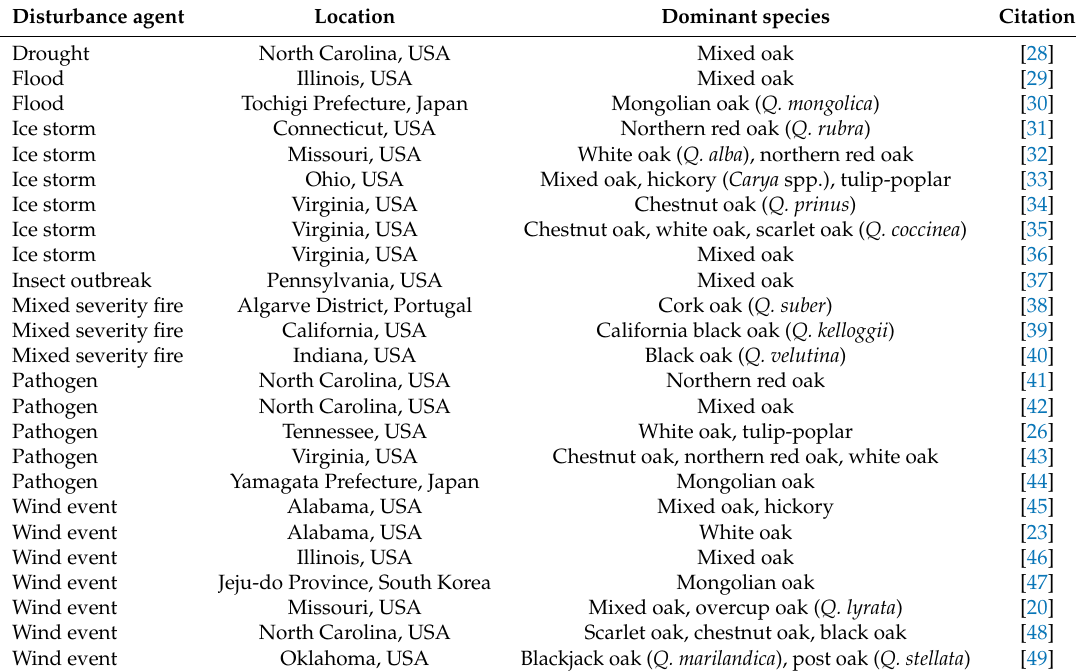
Table 1. Examples of studies that have examined intermediate-severity disturbances from a variety of disturbance agents in oak-dominated